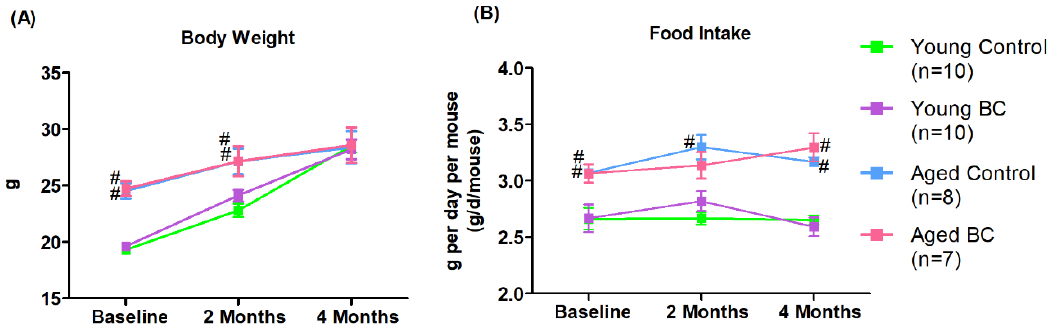
Figure 2. Comparison of mean body weight and daily food intake in young and aged mice consuming a control or blackcurrant (1% w / w ) diet for 4 months. ( A ) Mean body weight change over four months. ( B ) Mean daily food intake per mouse. Values are reported as mean ± SEM. Data were analyzed using an independent t -test. Young control ( n = 10), young BC ( n = 10), aged control ( n = 8), and aged BC ( n = 7). # Indicates significant difference by age in mice consuming the same diet. BC, blackcurrant.